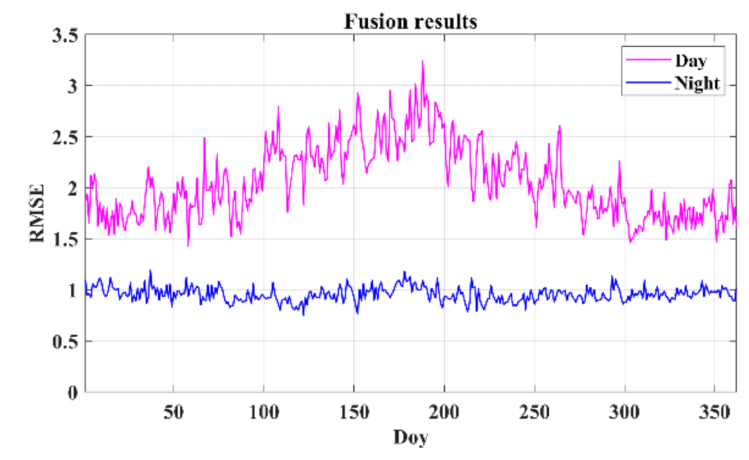
Figure 8. The RMSE of the fusion results.